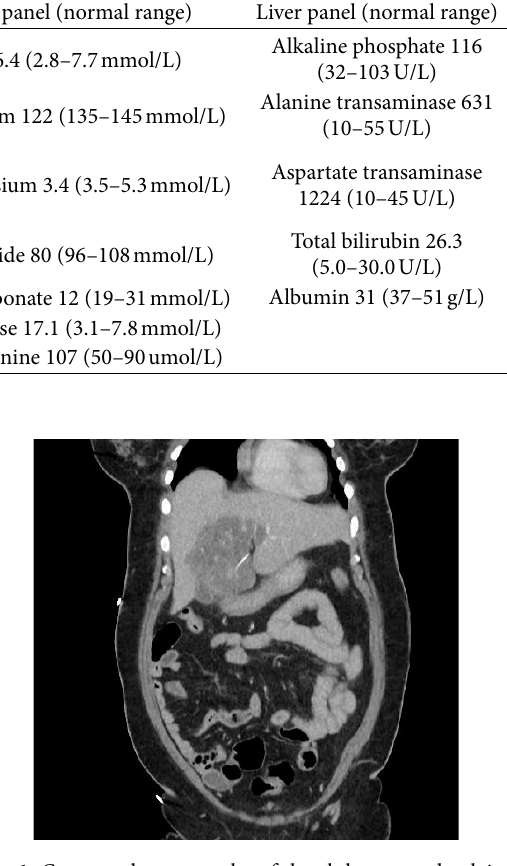
Figure 1: Computed tomography of the abdomen and pelvis with foreign body.